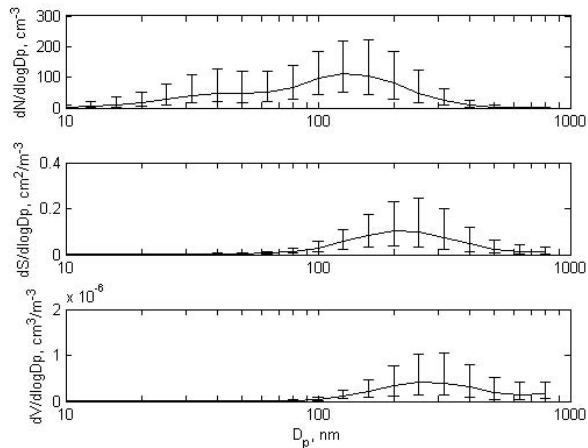
Fig. 4. Aerosol size distribution properties for the period of March 2000–March 2010 and 25–75th percentile ranges indicated. (a) Median aerosol number size distribution. Units in cm − 3 . (b) Median aerosol volume size distribution. Units in cm 3 m − 3 . (c) Median aerosol surface distribution. Units in cm 2 m − 3